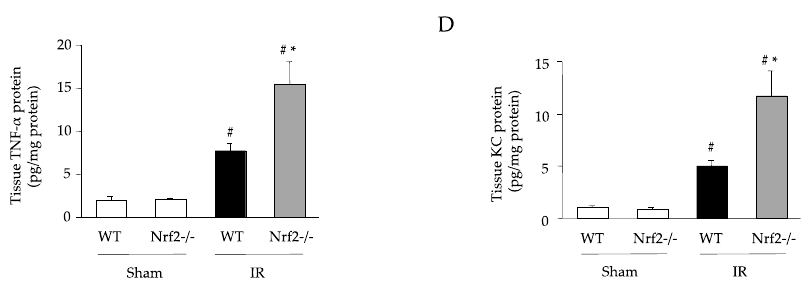
Figure 4. Effect of nuclear factor-erythroid 2-related factor 2 (Nrf2) deficiency on the inflammatory response in intestinal IR injury. ( A ) Luminal protein level (a Bio-Rad Protein Assay kit) ( n = 7), ( B ) MPO activity ( n = 7), ( C ) tissue TNF- α protein level, and ( D ) tissue KC protein levels (eBioscience ELISA kit) ( n = 7). Sham operation or intestinal IR injury was induced in the wild-type and Nrf2-deficient mice. Each value represents the mean ± SEM. # p < 0.05 compared with sham-operated WT mice; * p < 0.05 compared with IR-induced WT mice.